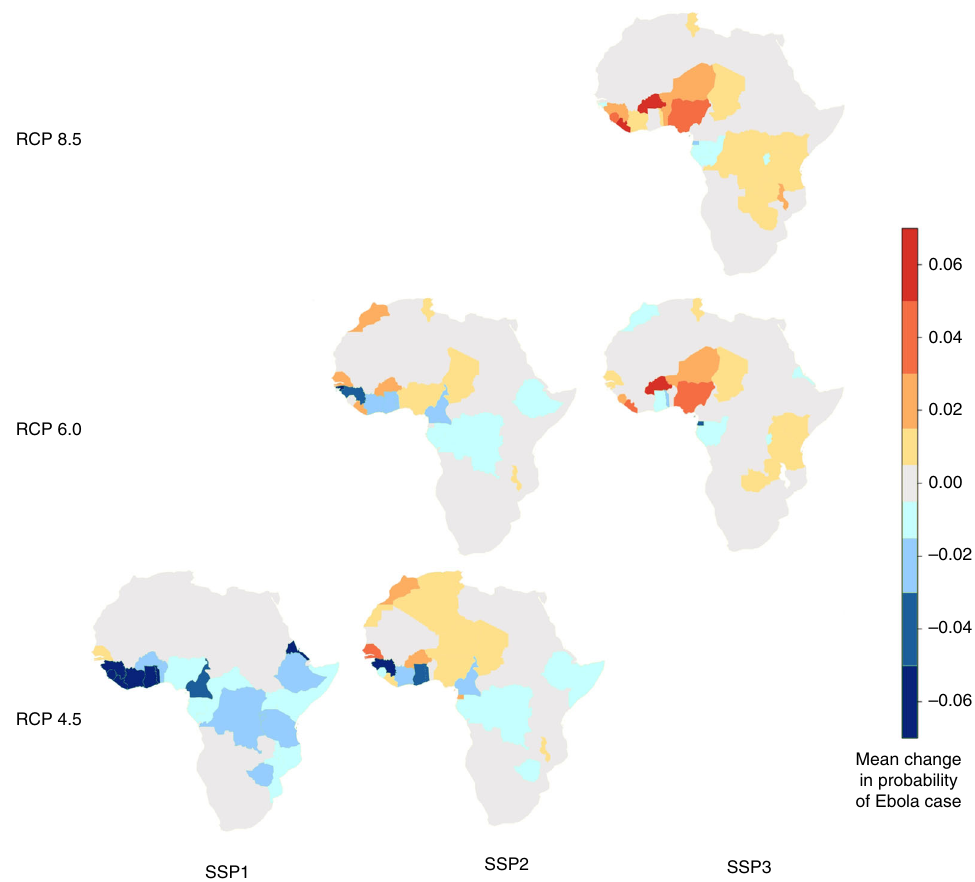
Fig. 5 Change in future risk of EVD cases caused by Zaire Ebola virus (EBOV) for 2070. Maps represent mean change in per grid cell (0.0416° — 5.6 km at equator) EVD case probability from zero (yellow) to − 0.06 (green) and 0.06 (red), aggregated at the country level with data from EMM simulations for 2070. Rows and columns show all reasonable combinations of the different scenarios of global change (GCAM-RCP4.5, AIM-RCP6.0, MESSAGE-RCP8.5 and SSP1 to